Question: Express in one sentence what the figure is showing.
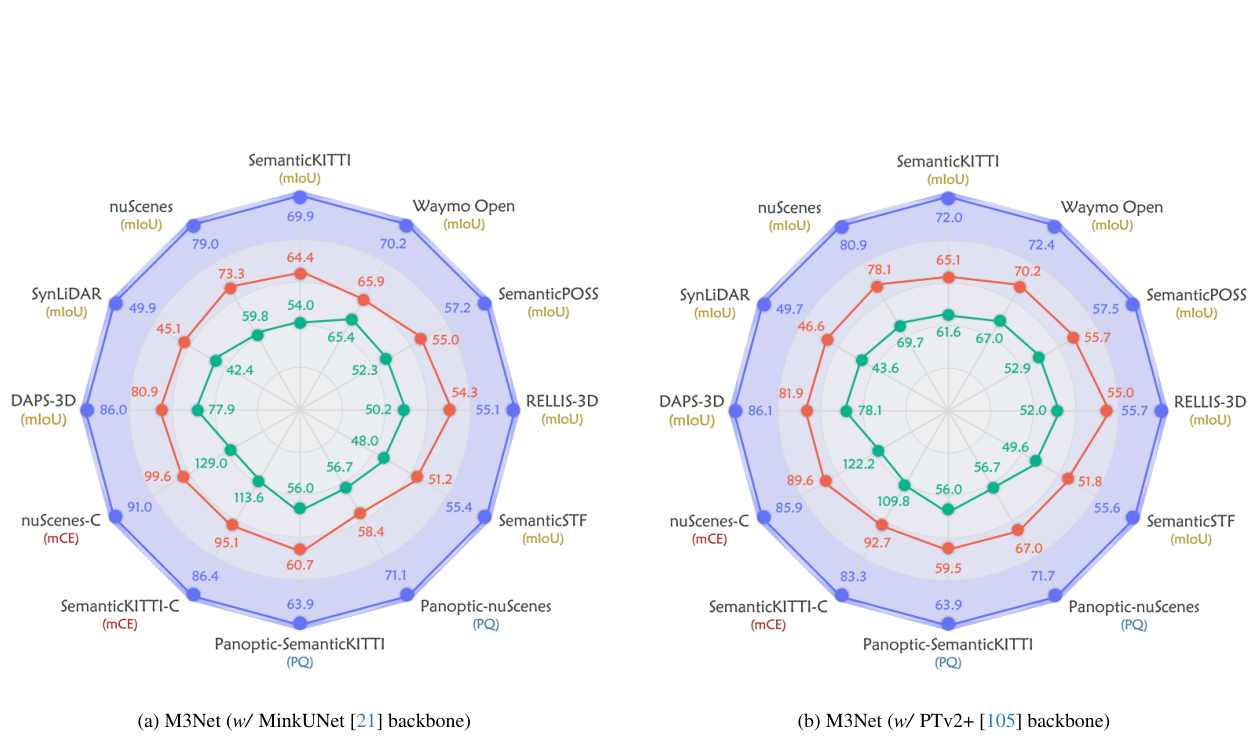
Answer: Performance comparisons among M3Net [•], Single-Dataset Training [•], and Na¨ıve Joint Training [•] across twelve LiDAR segmentation datasets. Subfigure (a): M3Net w/ a MinkUNet [21] backbone. Subfigure (b): M3Net w/ a PTv2+ [105] backbone. For better comparisons, the radius is normalized based on M3Net’s scores. The larger the area coverage, the higher the overall performance.